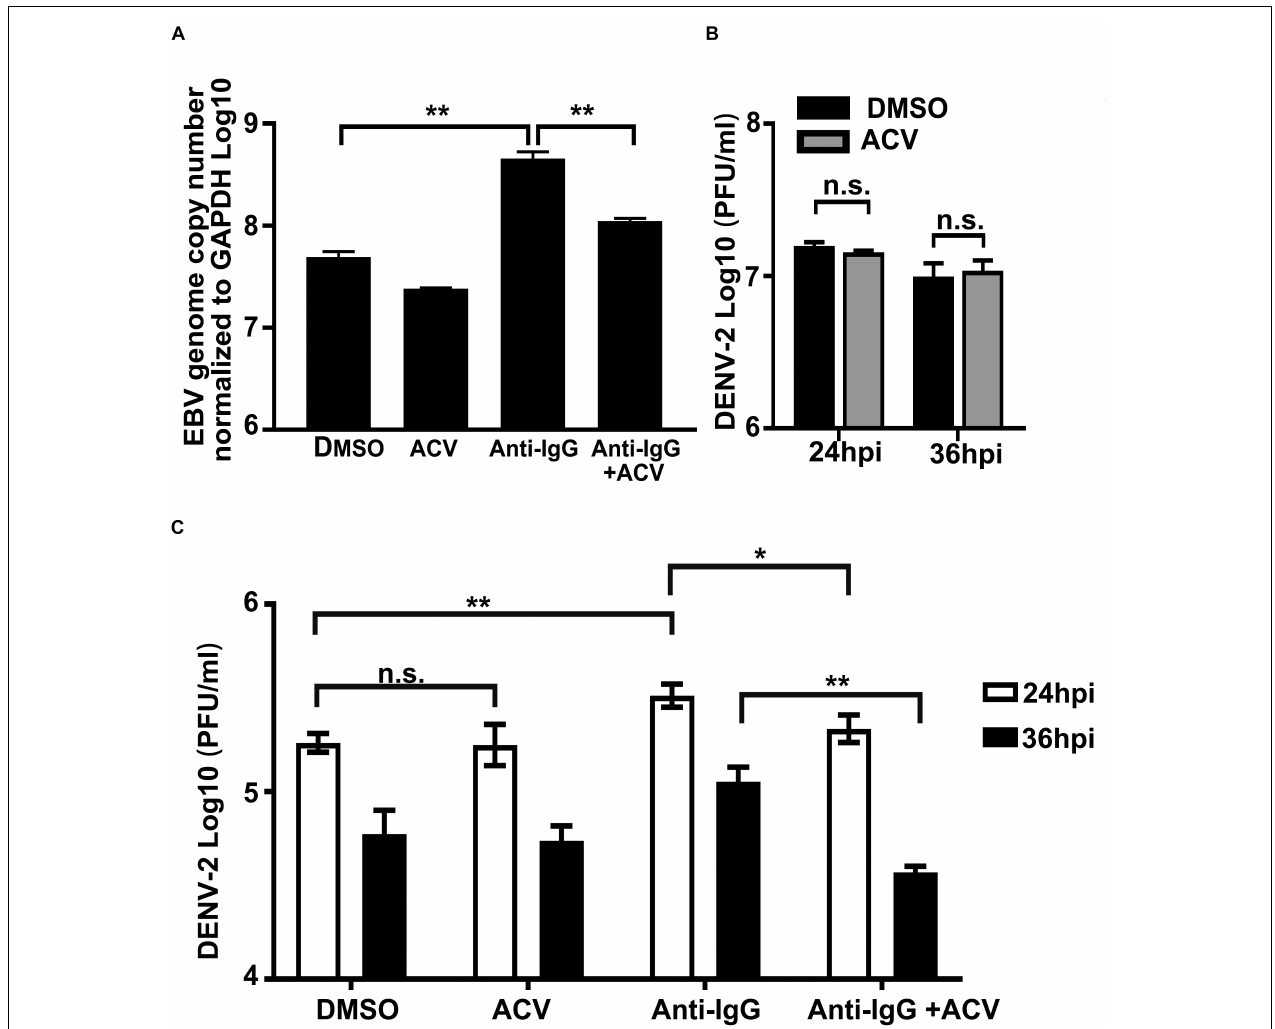
FIGURE 5 | Inhibition of Epstein–Barr virus (EBV) replication in Akata cells abolishes its enhancement effect on DENV-2 replication. (A) EBV + Akata cells were treated with dimethyl sulfoxide (DMSO), acyclovir (ACV), anti-human IgG antibody and DMSO, or anti-human IgG and ACV as described in section “Materials and Methods.” Relative EBV genome copy number was measured by qPCR. (B) EBV- Akata cells were infected with DENV-2 at a multiplicity of infection (MOI) of 10, DENV-2 titer in culture medium at 24 and 36 hpi was determined by plaque assay. (C) The four groups from panel A were infected with 10 MOI of DENV-2. At